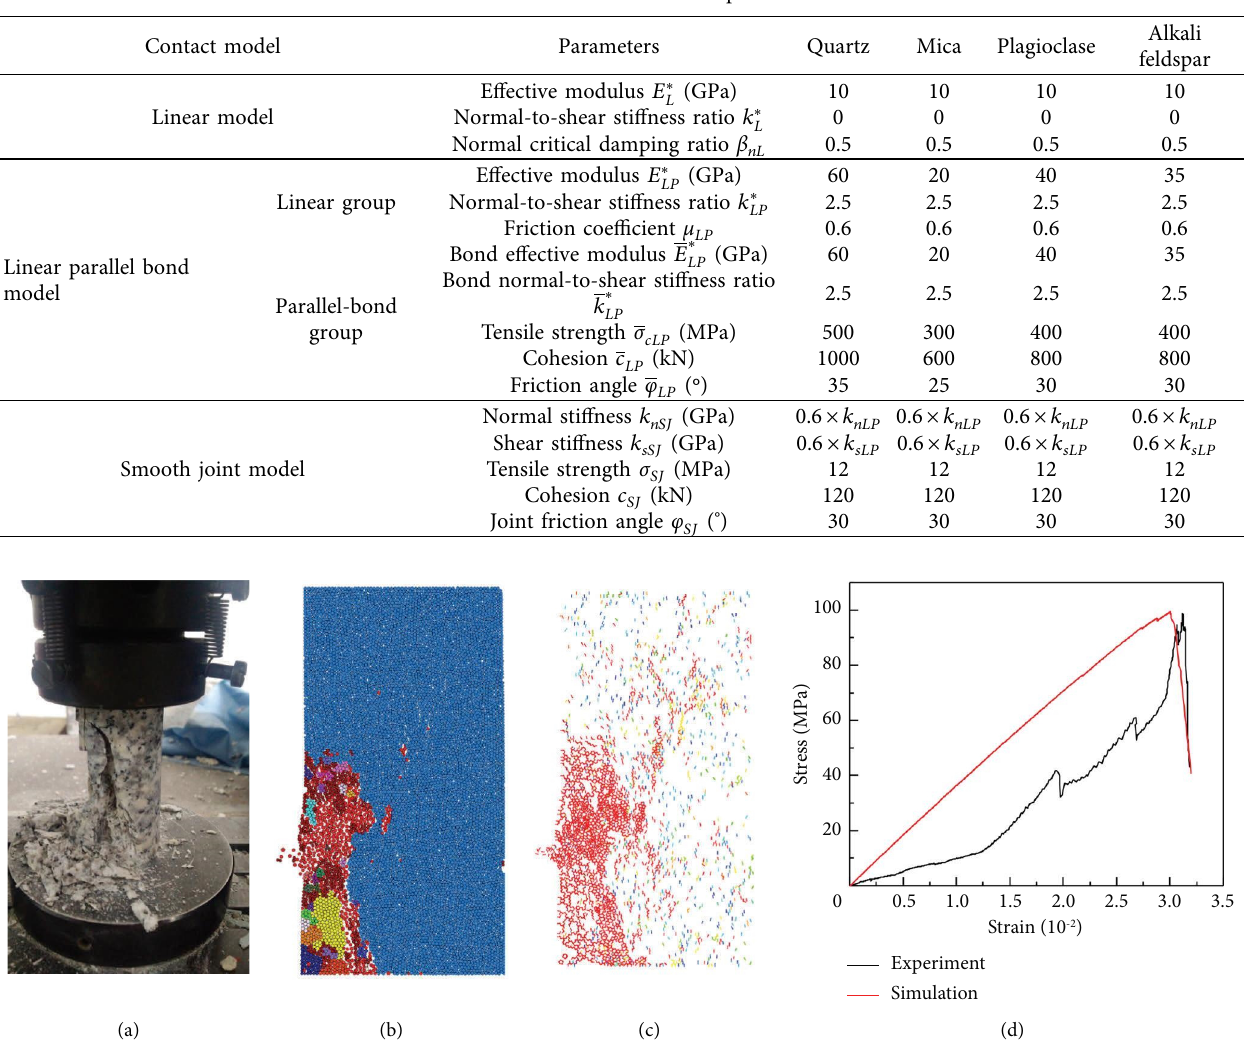
Figure 3: Uniaxial compressive test and simulation results: (a) uniaxial compressive test, (b) ball fragment in uniaxial compressive simulation, (c) DFN fractures in uniaxial compressive simulation, and (d) stress vs. strain